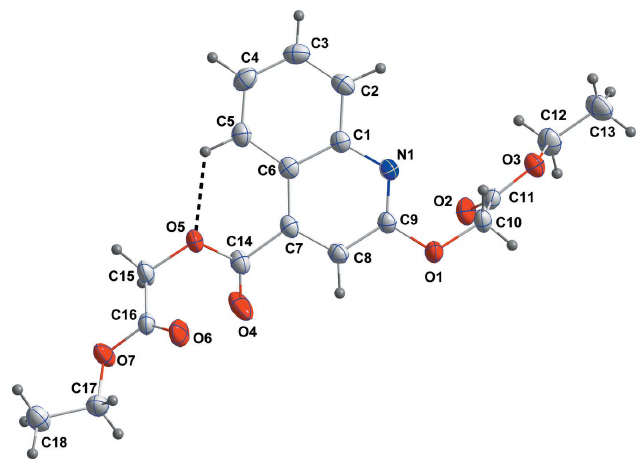
Figure 1 The title molecule showing 50% probability ellipsoids. The intra- molecular hydrogen bond is shown by a dashed